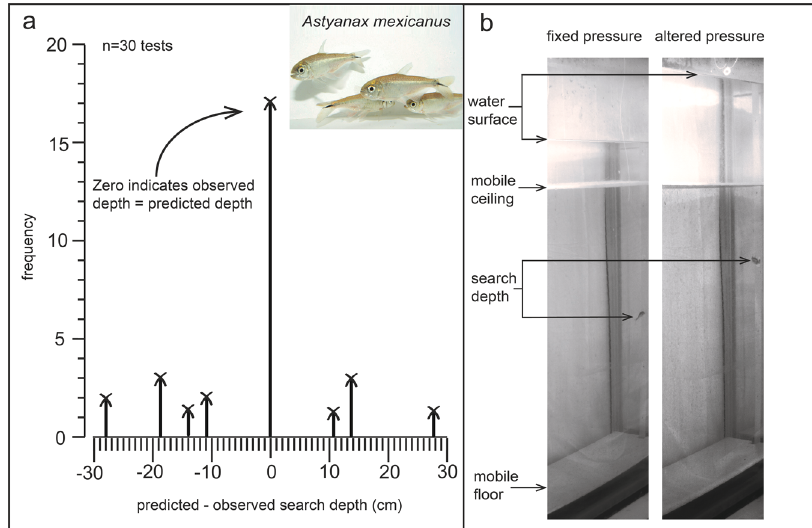
Fig. 1 Difference in observed and predicted search depth in the altered pressure phase. a Difference between the search depth we observed and the search depth we predicted according to the change in hydrostatic pressure in all 30 tests. A difference of zero means fi sh searched where we predicted according to hydrostatic pressure. b Stills from recorded footage of an individual during the fi xed pressure phase (left) and the altered pressure phase (right) where we added 15 cm of water and observed the fi sh respond by searching 15 cm higher in the tank, as